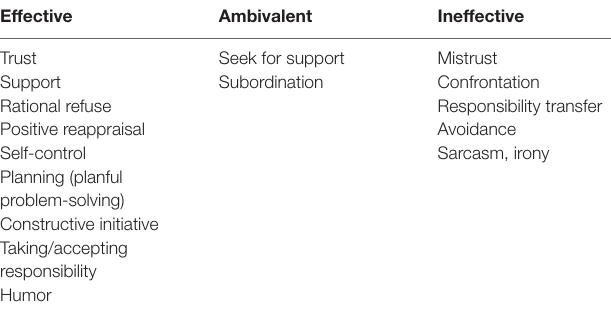
TABLE 1 | Coping strategies divided by communicative